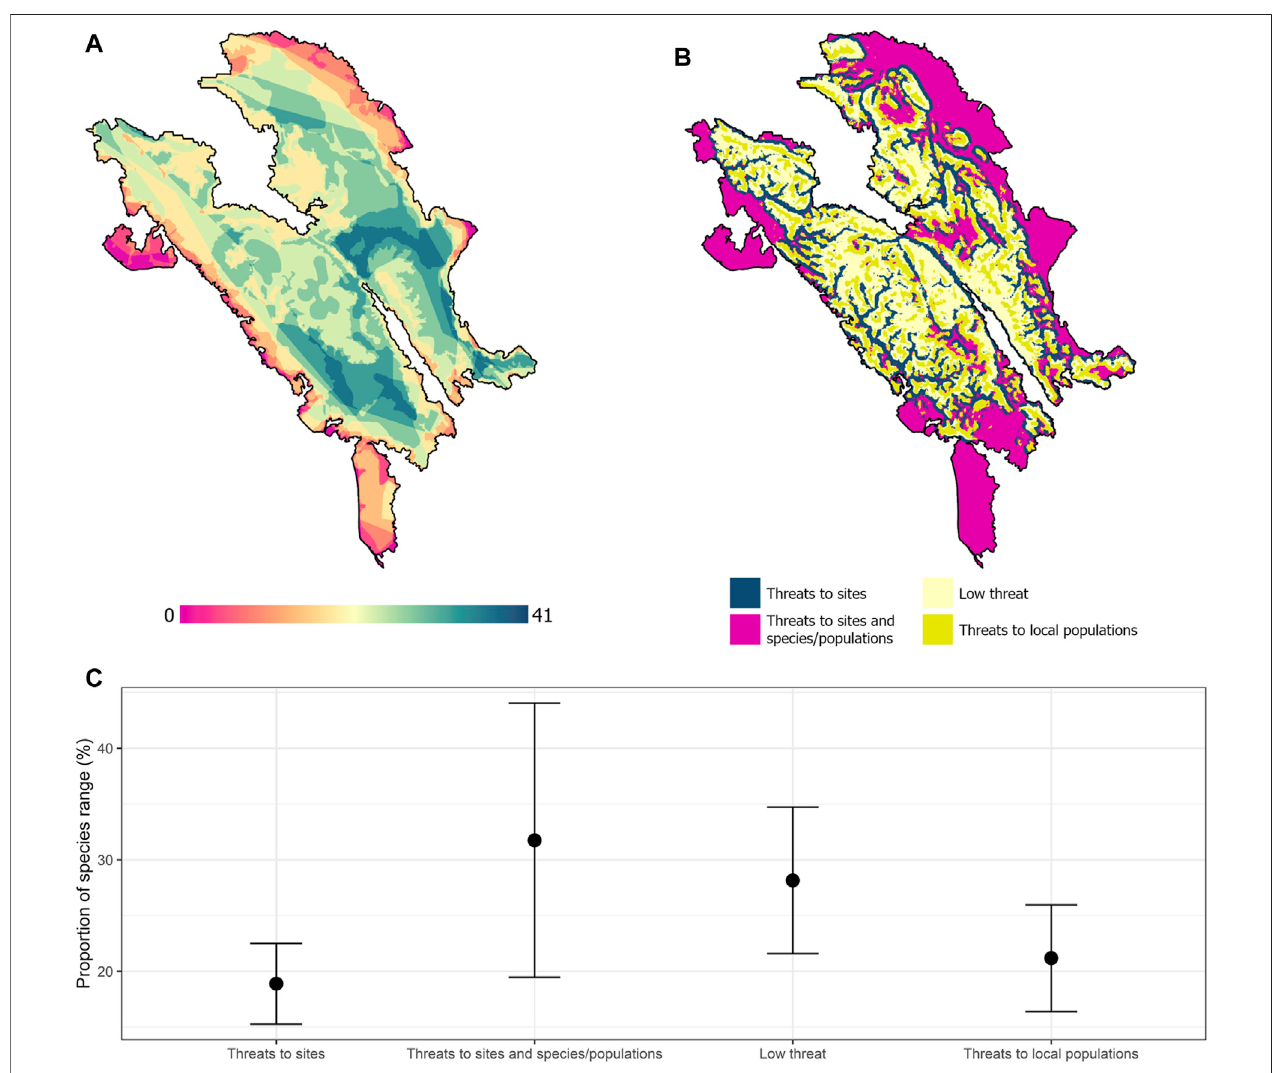
FIGURE 4 | Vulnerability assessment based on forward and backward velocities until 2050 (A) , current richness of mammal species in the Leuser Ecosystem (B) , mean and standard deviation in the proportion of 45 species ranges in each region within the different combinations of climatic velocity (C) .